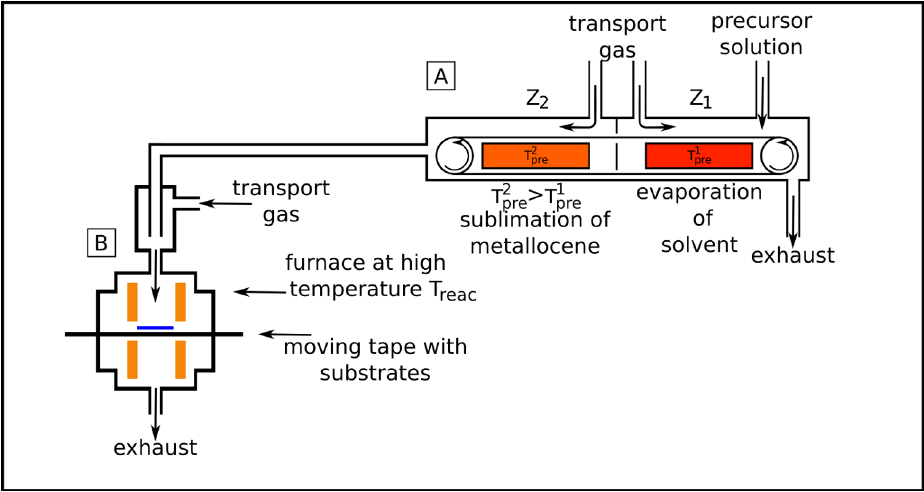
Figure 4. Setup of a LSCVD experiment. The precursor is prepared in device A. The solvent is evaporated at T 1 The ferrocene mass flow is diluted by additional transport gas flow. In device B the reaction takes place at the temperature T CNT on